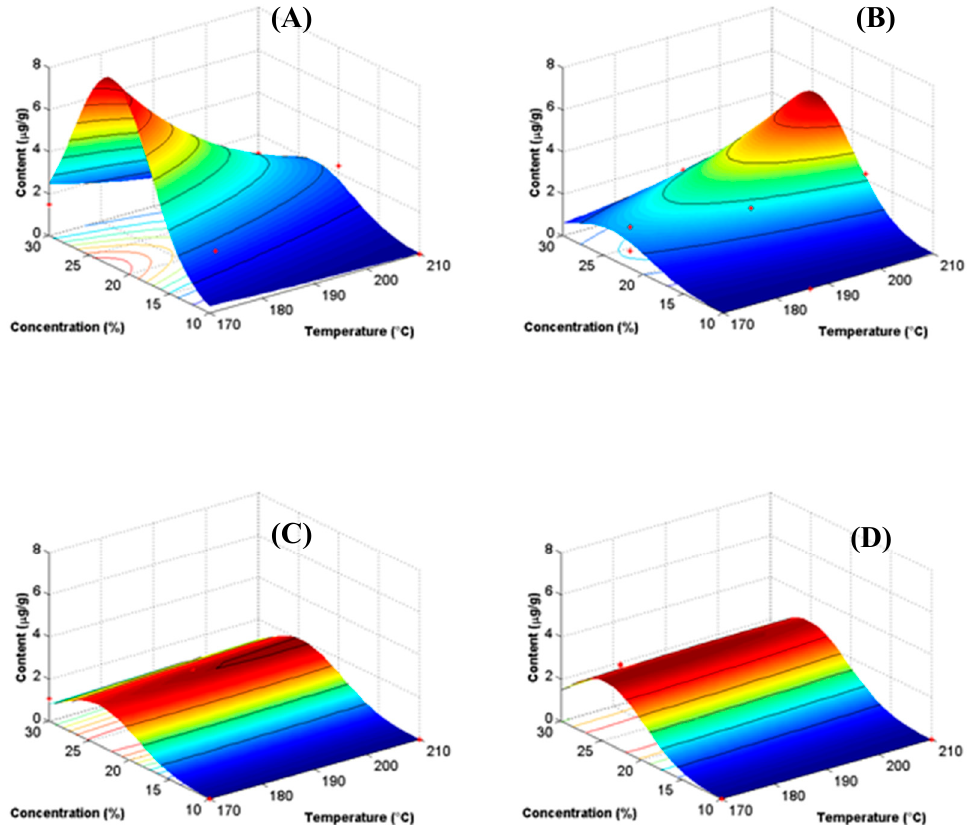
Figure 6. Response surface plots for the content of quercetin 3- D -galactoside in the dry powder. Content is expressed in micrograms of antioxidant per gram of dry powder ( µ g/g). ( A ) Mc, ( B ) M10, ( C ) M20, and ( D ) M40.